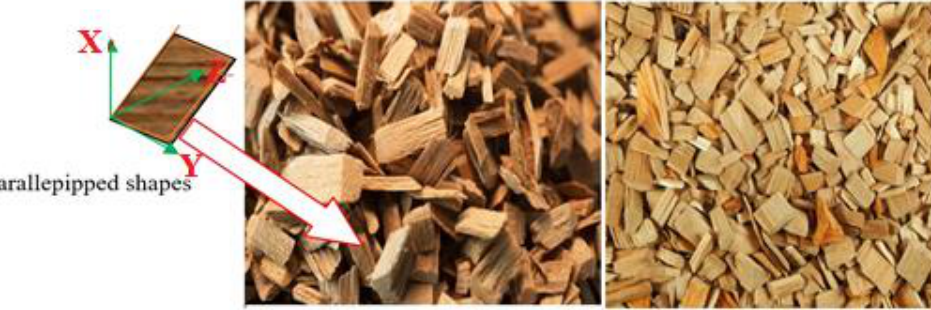
Figure 1. A typical wood chip showing predominant near-parallelepiped shapes [23].